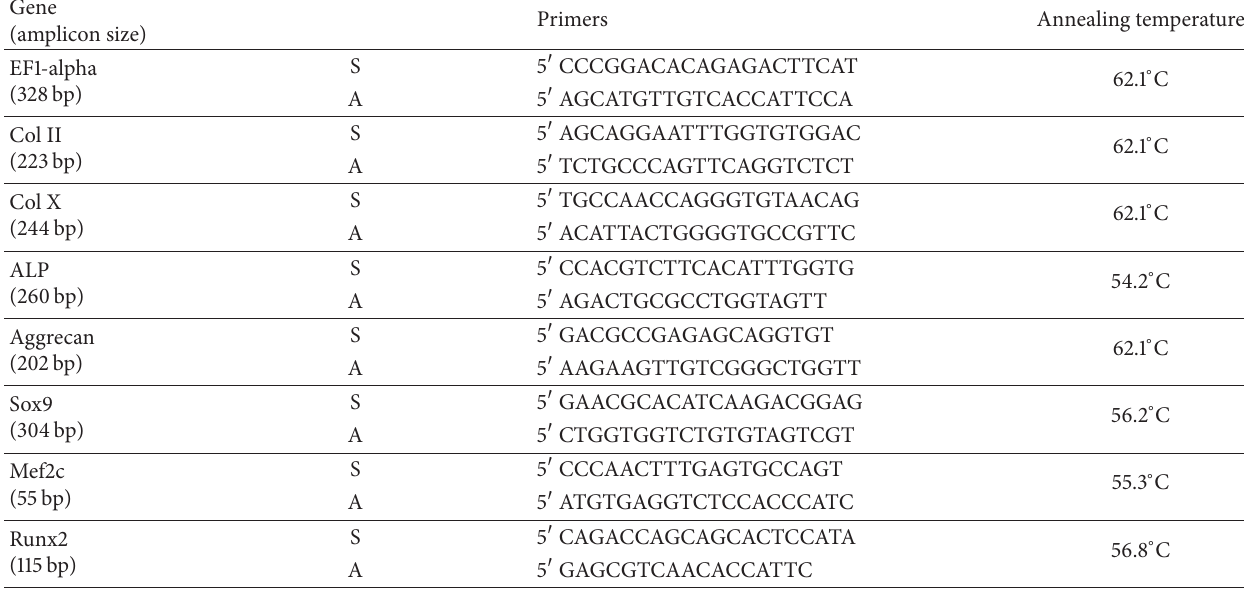
Table 1: Primers used in the qPCR